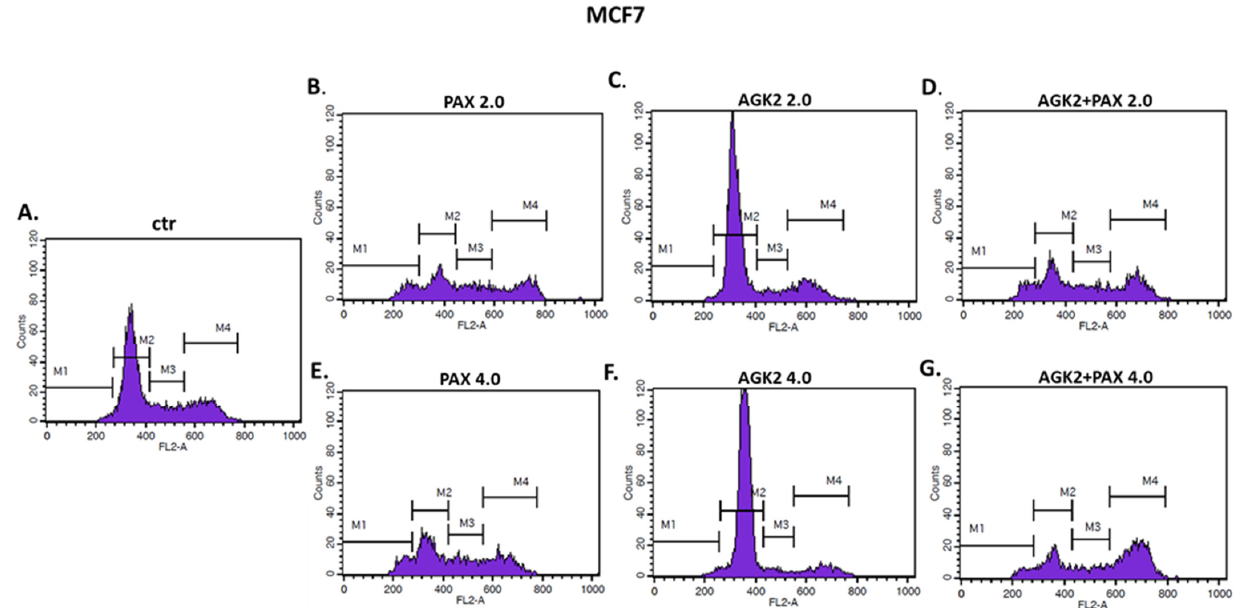
Figure 18. Representative histograms from the flow cytometry analysis of the MCF7 luminal-type breast cancer (BC) cells after a 48 h incubation with a medium (ctr) ( A ), paclitaxel (PAX) ( B , E ), AGK2 ( C , F ) and PAX + AGK2 ( D , G ) (2.0 = IC 50 + IC 50 , 4.0 = 2IC 50 + 2IC 50 ). M1—G0 (pre-G1) phase; M2—G1 phase; M3—S phase; M4—G2